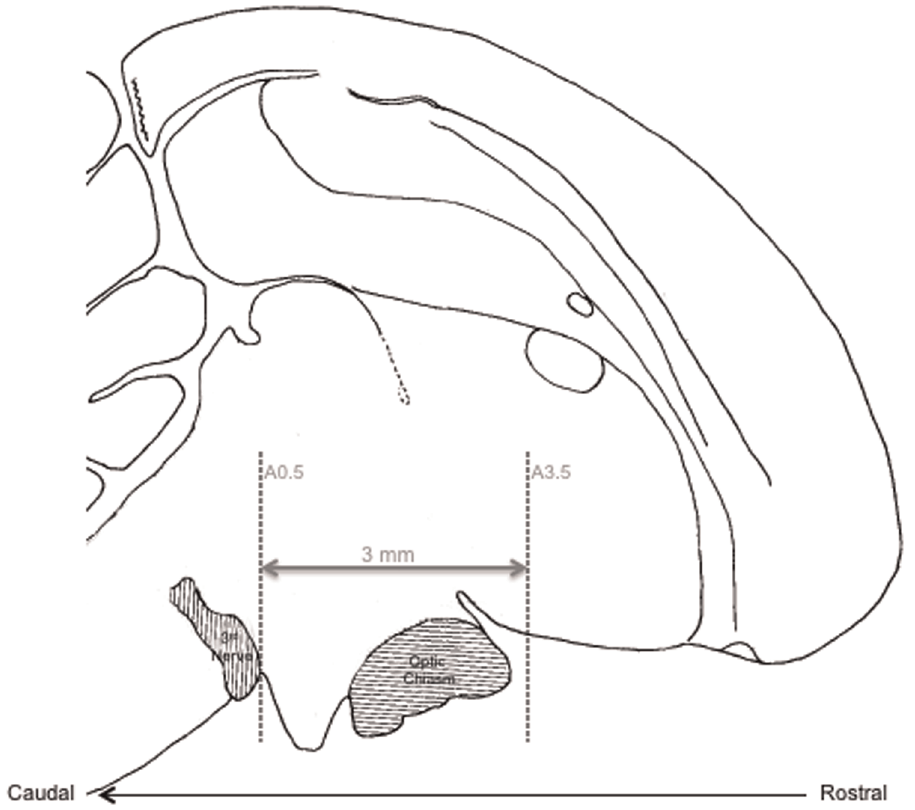
Figure 5. Mid-line sagittal drawing (adapted from [ 42 ] ) of a passerine brain. Dashed vertical lines represent approximate starting and ending points of tissue punches through the 3 mm of hypothalamus. Tissue punches were collected on alternating right and left sides of each section beginning at approximately A3.5 and ending at approximately A0.5.